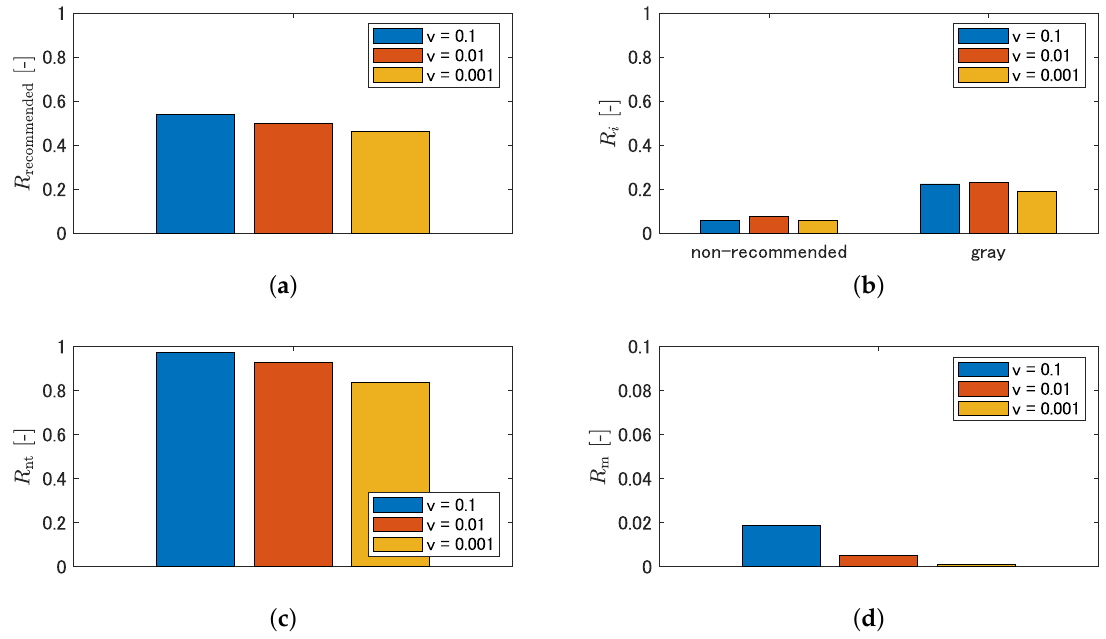
Figure 16. Quantitative characterization by varying loss weight for non-traversable area; ( a ) detection rate of recom- mended area; ( b ) detection rate of non-recommended area and gray area; ( c ) detection rate of non-traversable area; and ( d ) misclassification rate of non-traversable